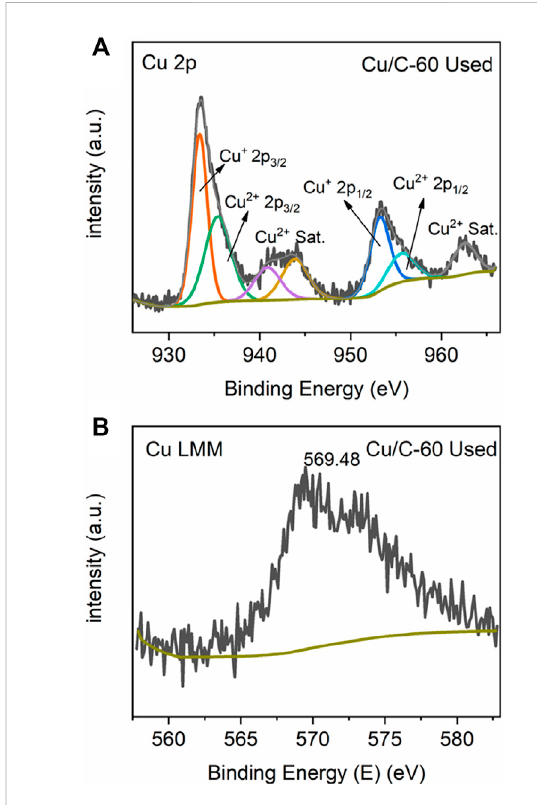
FIGURE 8 (A) Cu 2p and (B) Cu LMM XPS spectra of the used Cu/C- 60 after GOR reaction.